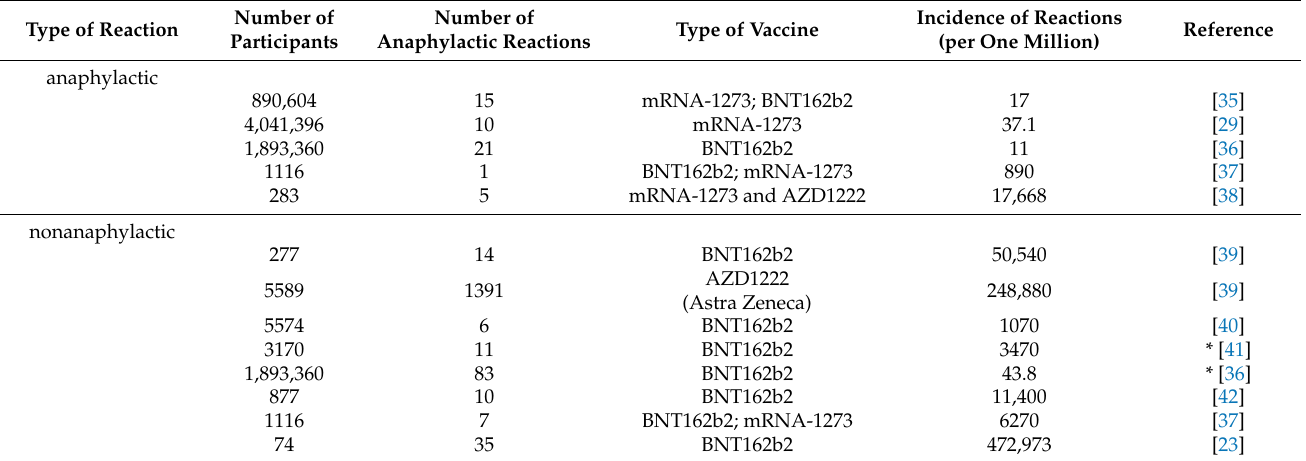
Incidence rates of anaphylactic and nonanaphylactic hypersensitivity reactions to COVID-19